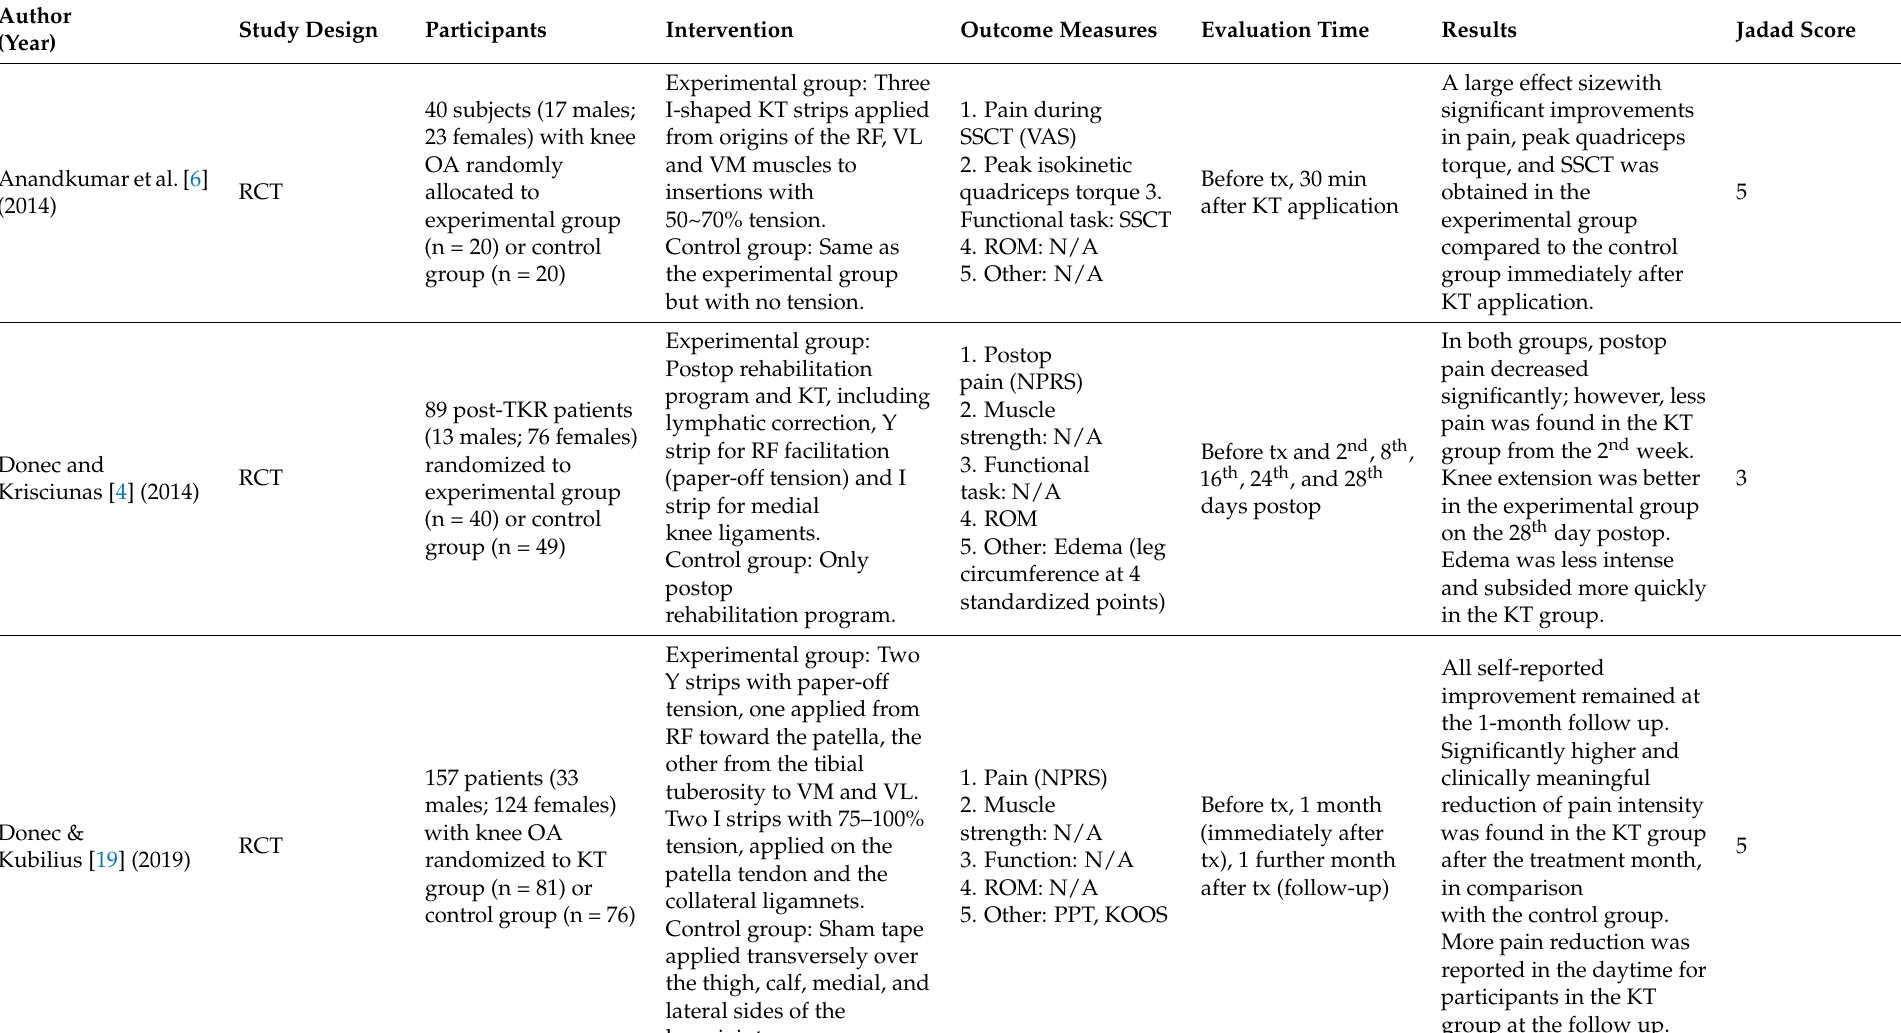
Table 1. Study characteristics of KT interventions in knee OA